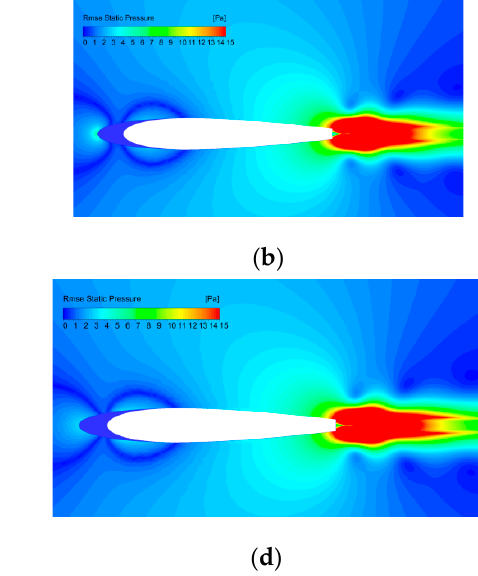
Figure 11. Distribution of the pressure fl uctuations on the airfoil ʹ s surface: ( a ) baseline; ( b ) A10W10.